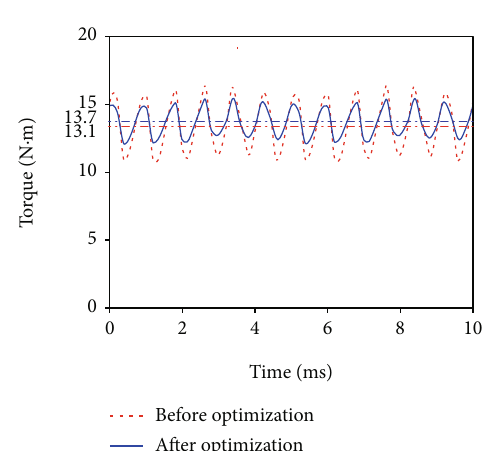
Figure 11: Performance comparison before and after optimization.